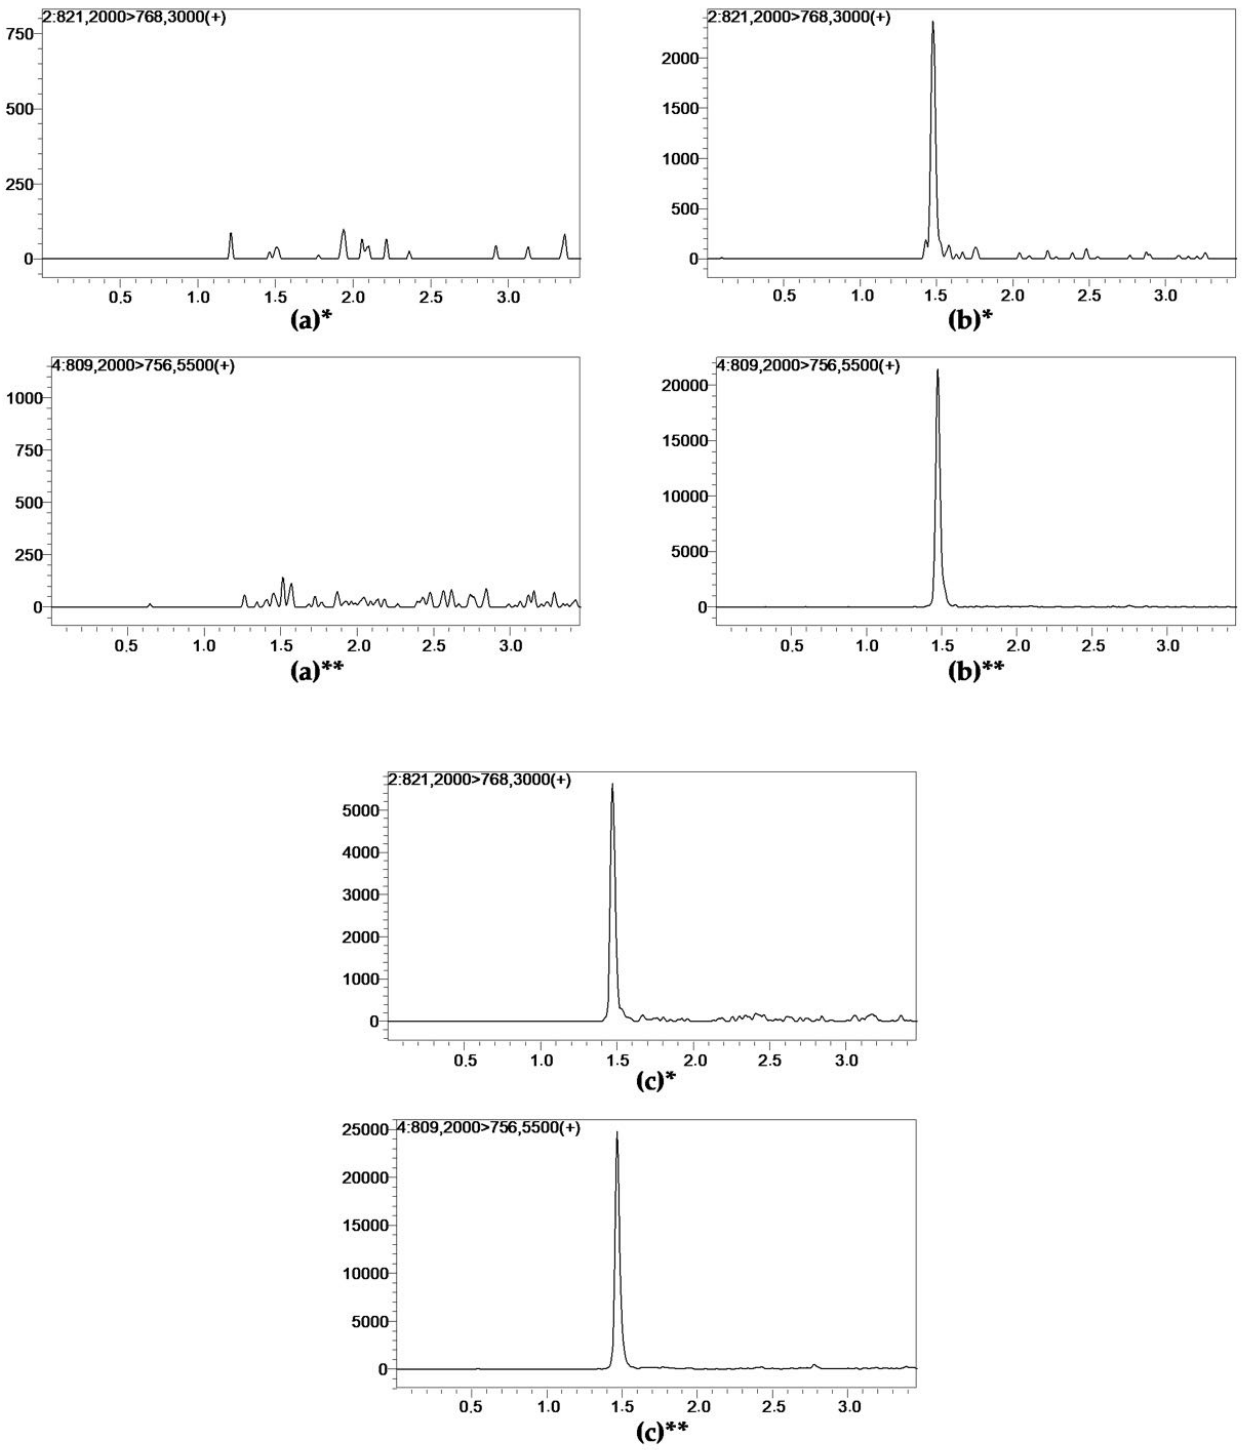
Figure 1. Representative LC-MS/MS chromatograms of ( a ) blank plasma ultrafiltrate; ( b ) tacrolimus at the lower limit of quantification (0.1 pg/mL); ( c ) unbound tacrolimus in a patient ultrafiltrate sample. * Tacrolimus reference standard (99.1% purity). ** Internal standard